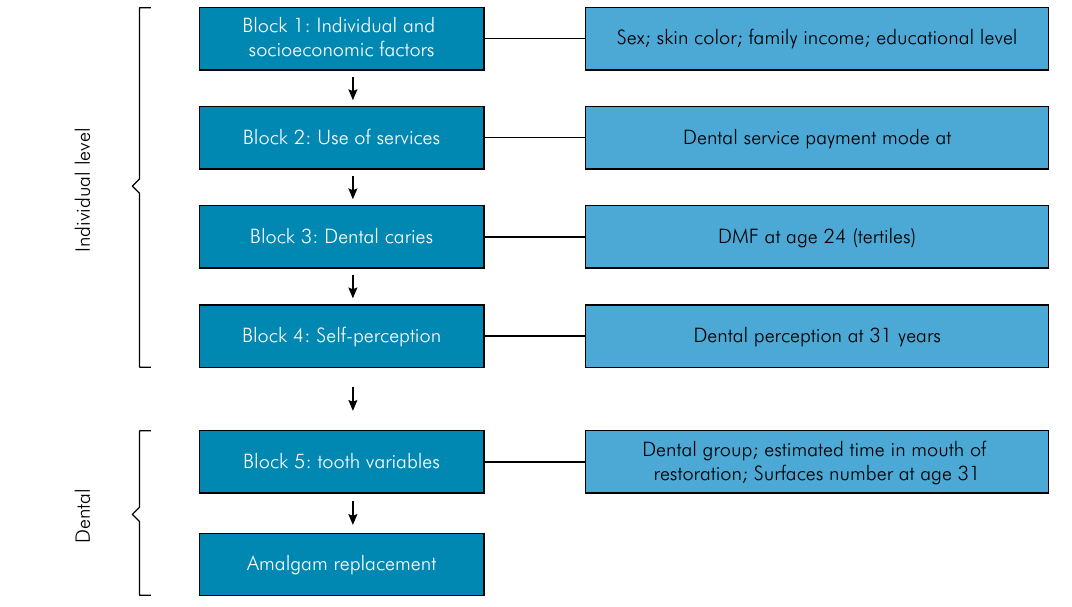
Figure 1. Theoretical model for analysis of amalgam replacement.